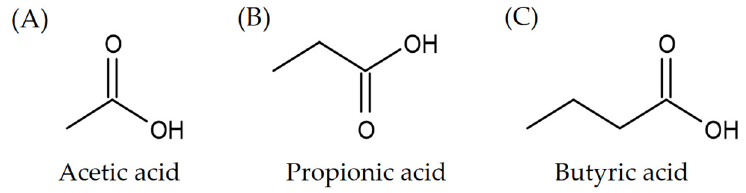
Figure 1. ( A – C ) The chemical structures of three major SCFAs.